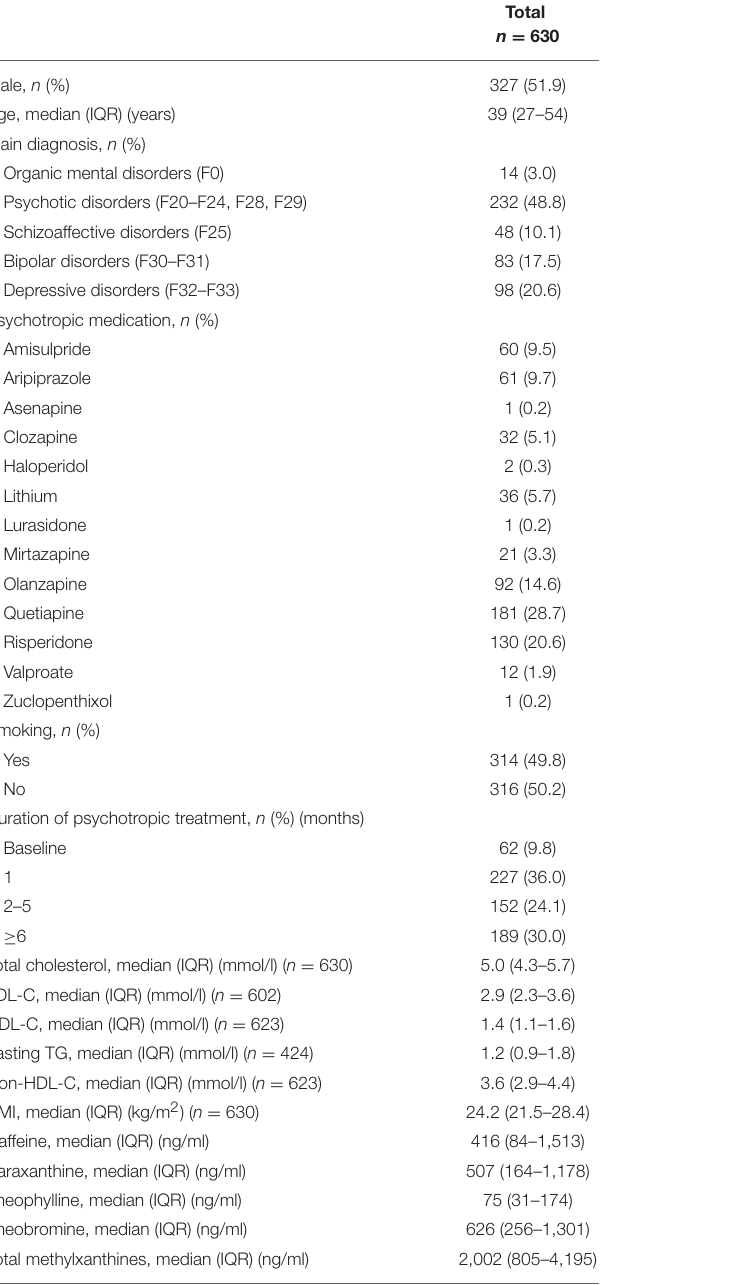
TABLE 1 | Demographic parameters and plasma levels of lipids and of methylxanthines in patients receiving psychotropic